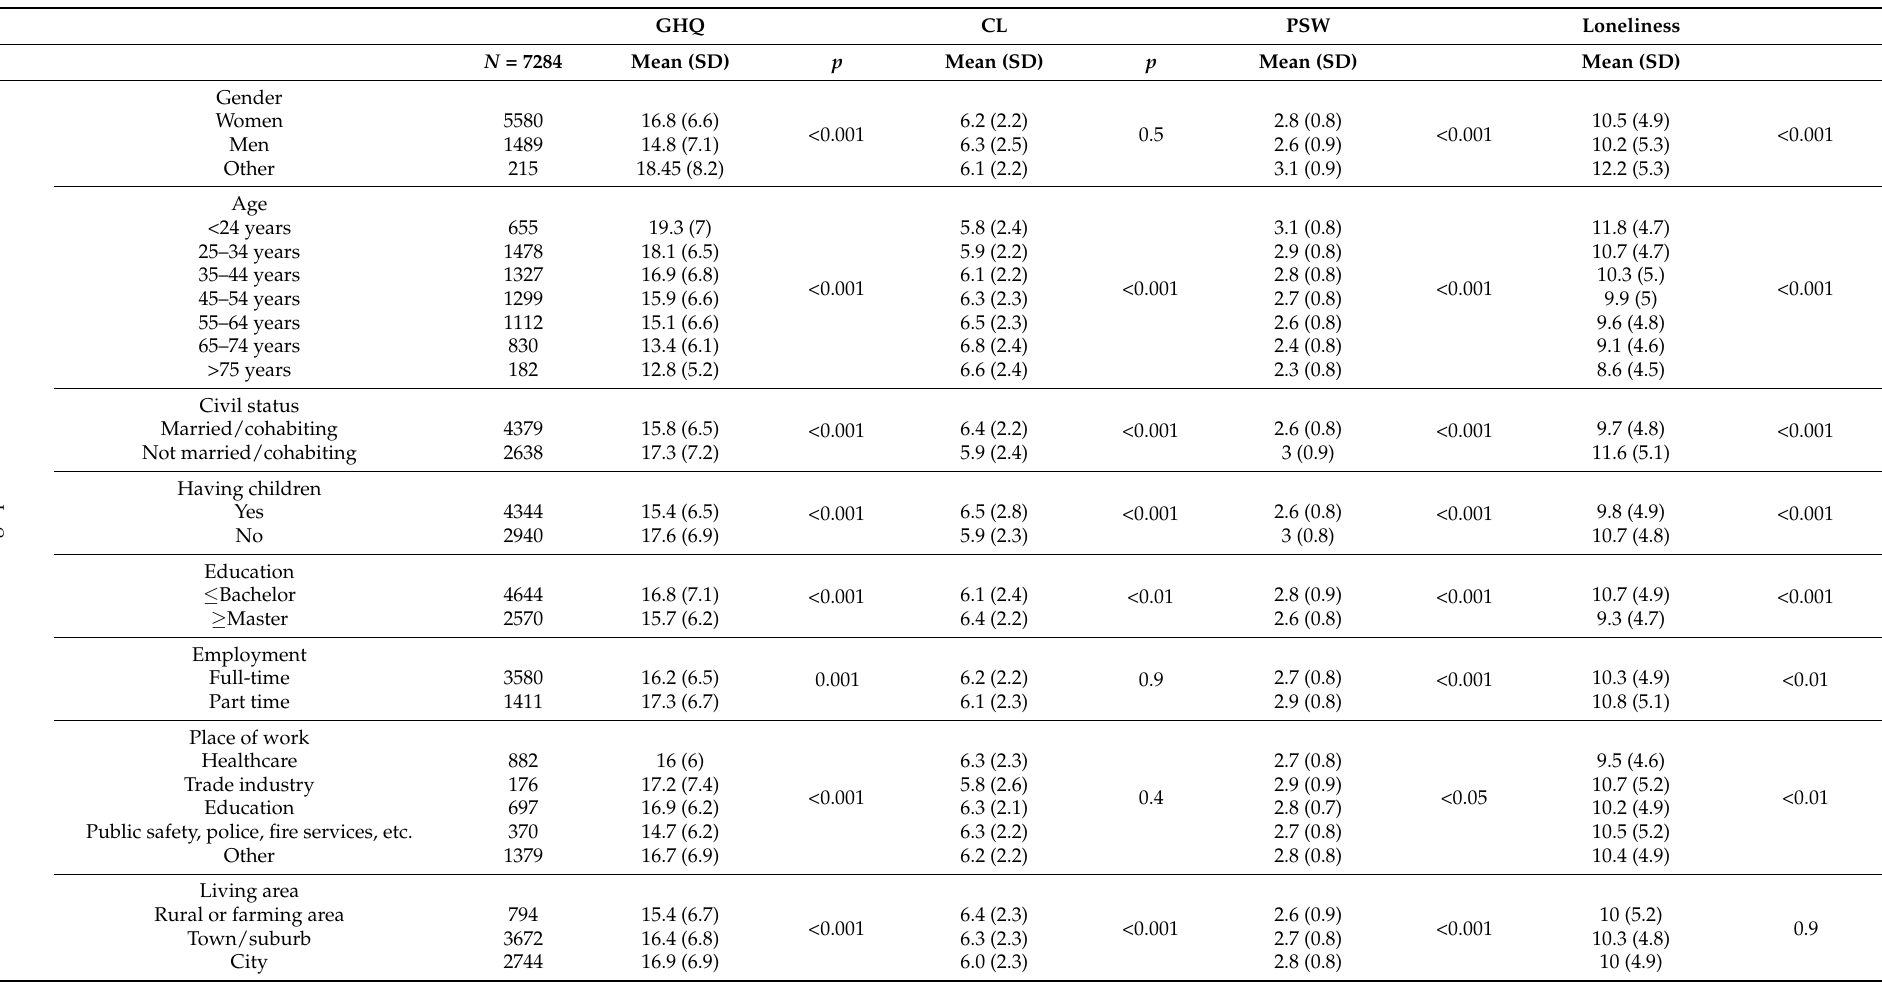
Table 2. Mental health, overall well-being, quality of life and loneliness in sample subgroups nine months after the COVID-19 outbreak in the total sample from April and November